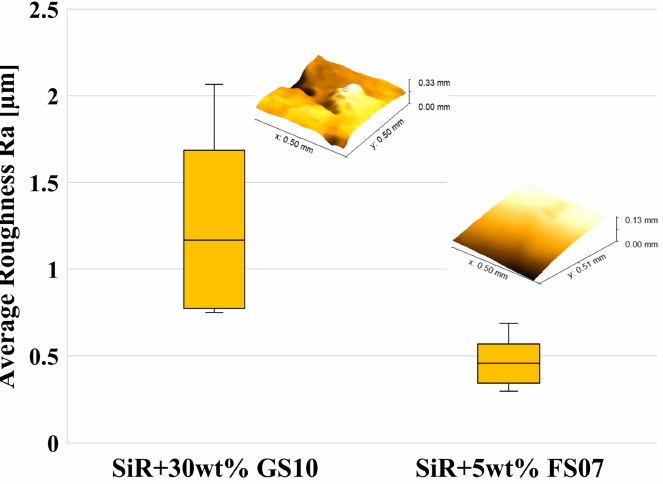
Figure 12. Statistical boxplot representation of 10 values of R a for the sampled areas shown for each composite. The center bar represents the median value, the top and bottom box edges represent the 25th and 75th percentile values, respectively, while the top and bottom markers represent the minimum and maximum values of R a ,